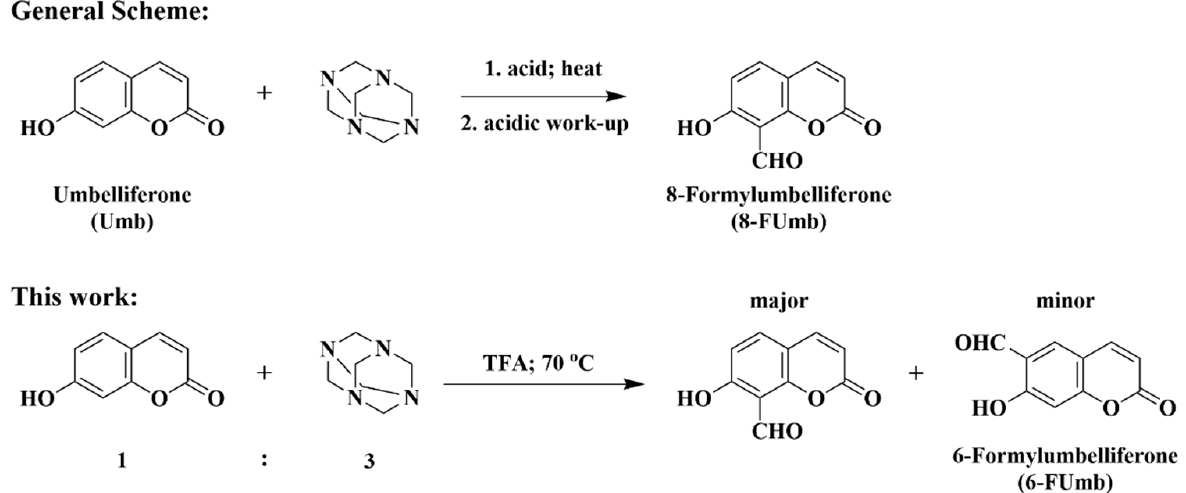
Figure 1. Detection of ortho -formylated umbelliferones as the products of the Duff reaction: ( A ) HPLC chromatogram of the reaction mixture before (blue) and after (green) 30 min reaction under the chosen reaction conditions. Conditions: column: Agilent Zorbax ® Eclipse XDB C18 Solvent Saver Plus (3.5 μ m; 3.0 × 75 mm); mobile phases: (A) water + 0.01% TFA, (B) acetonitrile + 0.01% TFA; gradient: 80% A and 20% B for 10 min; flow rate: 0.6 mL min − 1 ; temperature: 30 °C; injection volume: 20 μ L; DAD detection: 254 nm; ( B ) Schematized representation of TLC analysis of the starting Umb and the reaction mixture (RM) after reacting for 30 min. Conditions: TLC Plates: Merck "TLC Silica gel 60 ″ ; single ( left panel ) or triple ( right panel ) elution with CH 2 Cl 2 + 0.1% TFA; visualization: 365 nm.